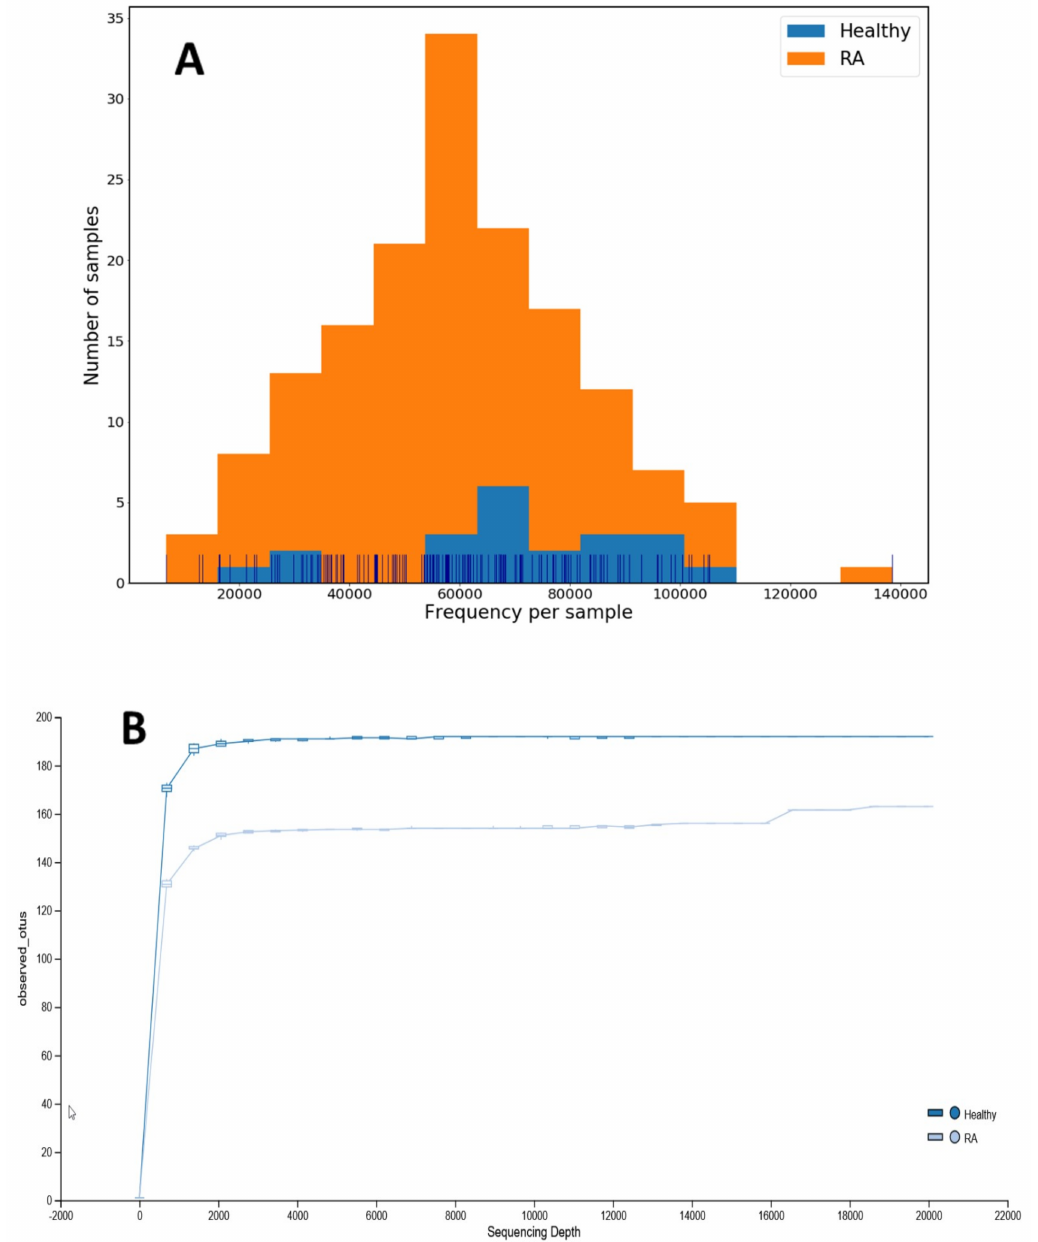
Figure 1. ( A ) The distribution of frequency of features (operational taxonomic unit, OTU) in each sample from patients with rheumatoid arthritis and healthy controls. ( B ) A rarefaction curve shows a correlation between numbers of OTUs and the number of